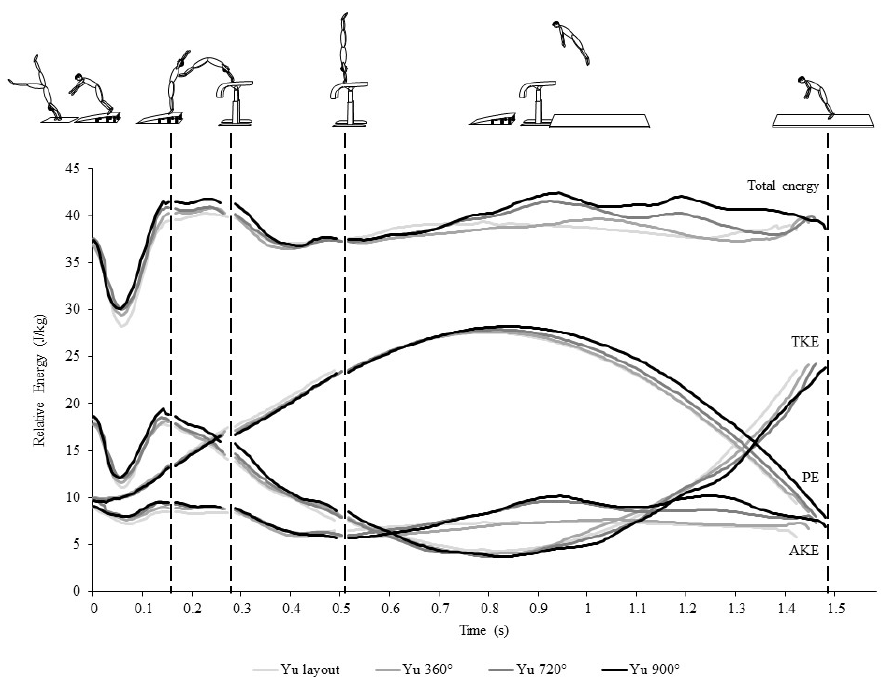
Figure 5. Averaged flux of different energy forms across the different vault phases of simple and difficult Yurchenko vaults (Yurchenko layout without layout (n = 5) and with 360° (n = 4), 720° (n = 7), and 900° (n = 4) of rotation around longitudinal axis during second flight phase). TKE: translational kinetic energy; PE: potential energy; and AKE: angular kinetic energy.